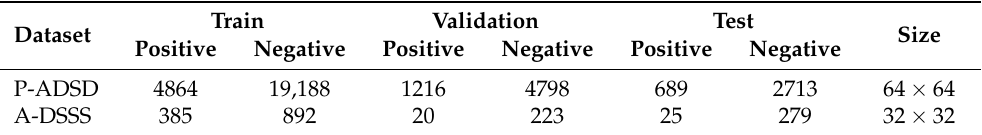
Table 2. Datasets